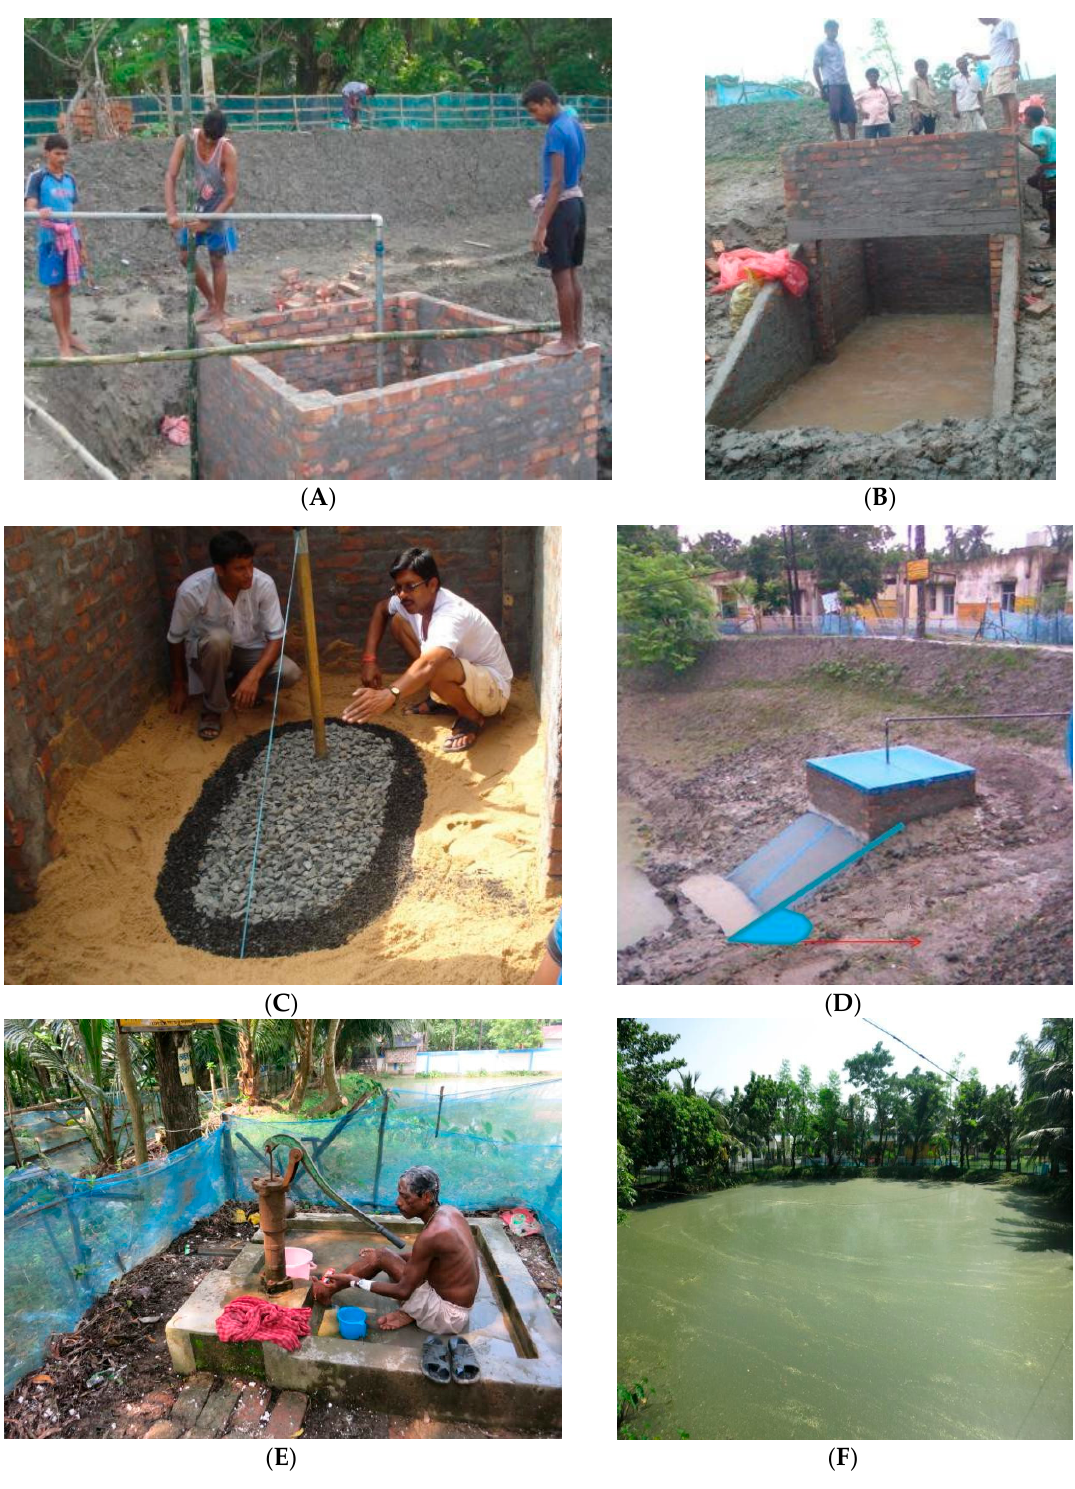
Figure 2. ( A – D ) construction of the submerged pond sand filter in the pond; ( E ) hospital patient pumping filtered water from the submerged filter through the manual hand-pump; and ( F ) pond, full.